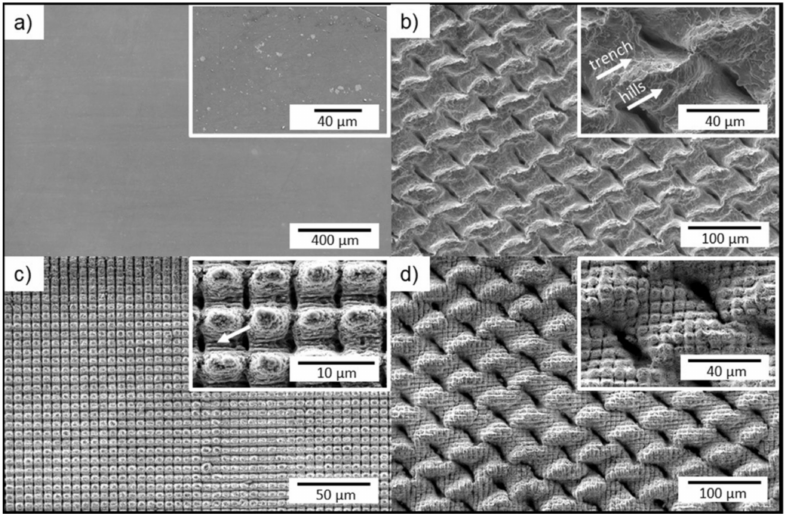
Figure 17. SEM images of ( a ) An original Al 2024 reference, ( b ) The mesh-like structure processed with DLW, ( c ) The pillar-like DLIP structures with a spatial period of 7 µ m (the arrow in the inset indicates the line-like LIPSS), and ( d ) A hierarchical structure resulting from the combination of DLW and DLIP (Reprinted from [117] with permission from